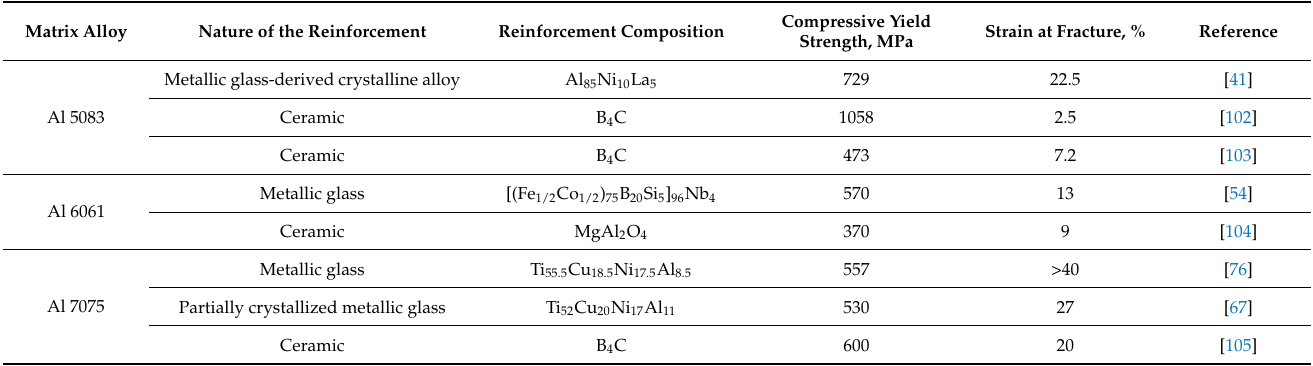
Table 5. Compressive yield strength–fracture strain combinations of several Al alloy matrix compos- ites reinforced with different phases (all composites were obtained via the powder metallurgy